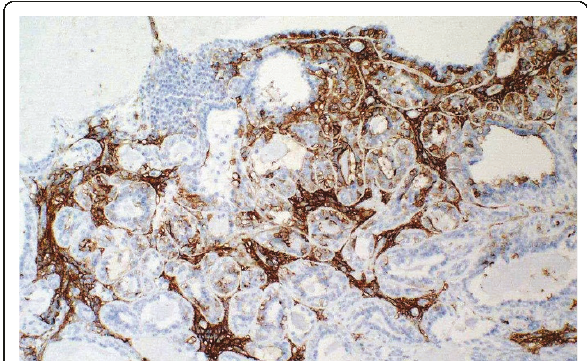
Figure 4 The myoepithelial component is positive for actin .